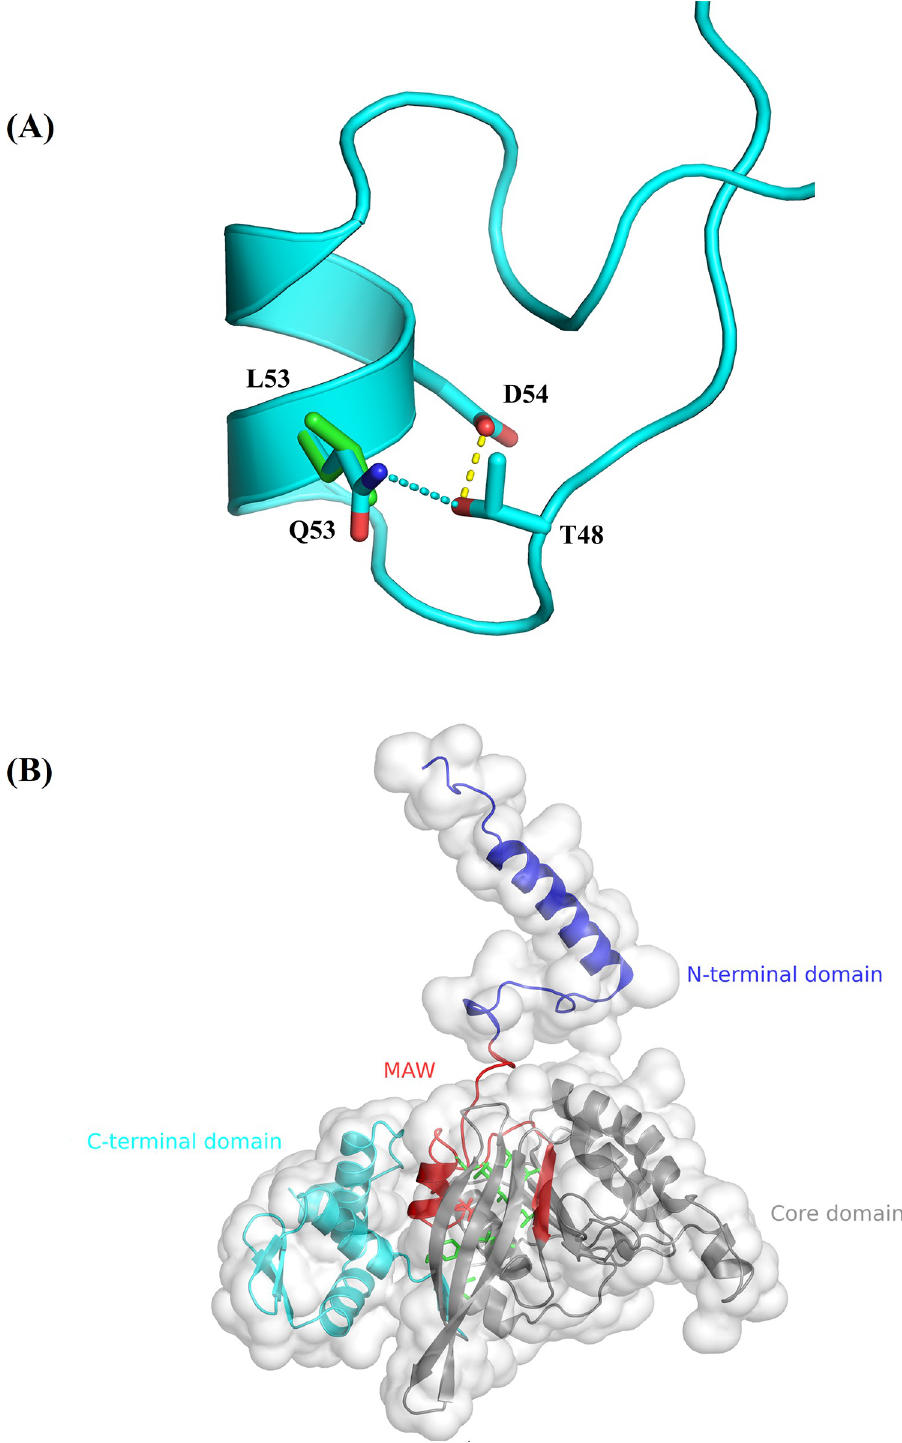
Fig 6. Residue 53 environment in HsRecA structure. (A) Superposition of the local view of the MAW motif, with residue side chains drawn as sticks–green for the wild type and cyan for the L53Q). The cyan dashed line shows the hydrogen bond that connects Q53:NE2 to T48:OG1 (present only in the mutant structure), the yellow dashed line shows hydrogen bonds that connect T48:OG1 to D54:OD1 (present in both wild-type and mutant structures). (B) Overall view, the MAW motif is shown in red (sticks shown for Gln53 side chain), buried within the hydrophobic